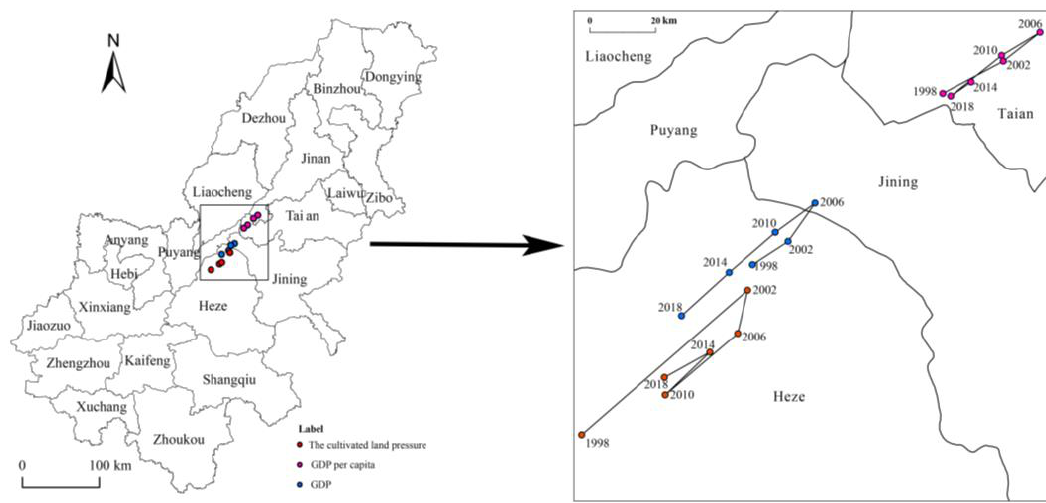
Figure 6. Center of gravity of the CLP index, GDP and per capita GDP in the AALYR.